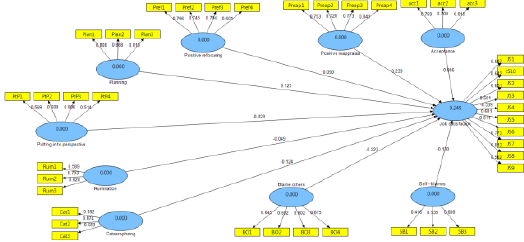
Fig. 3 . Results of PLS structural Sub model analysis (Smart PLS export